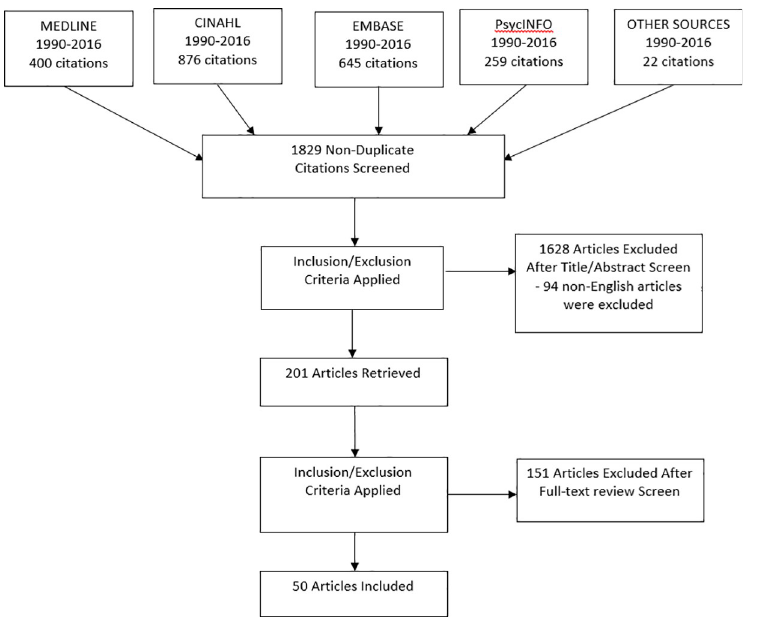
Fig 1. Modified PRISMA flow